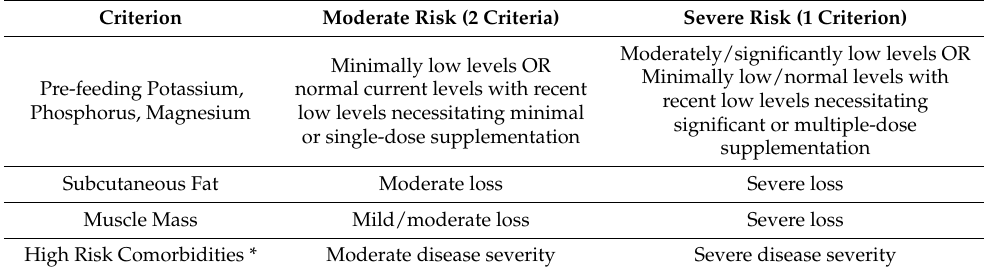
Table 2. Prevention and treatment of refeeding syndrome in adults [18]. Aspect of Care Recommendations Initiation of